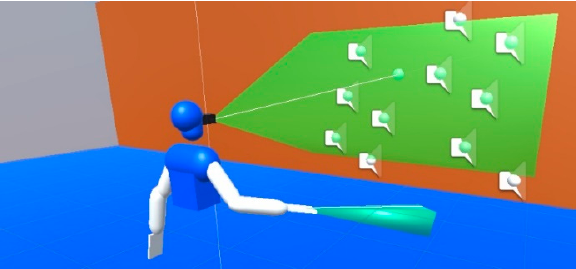
Figure 6. Detection areas for the acoustic (PVAS) and virtual-cane haptic feedback.